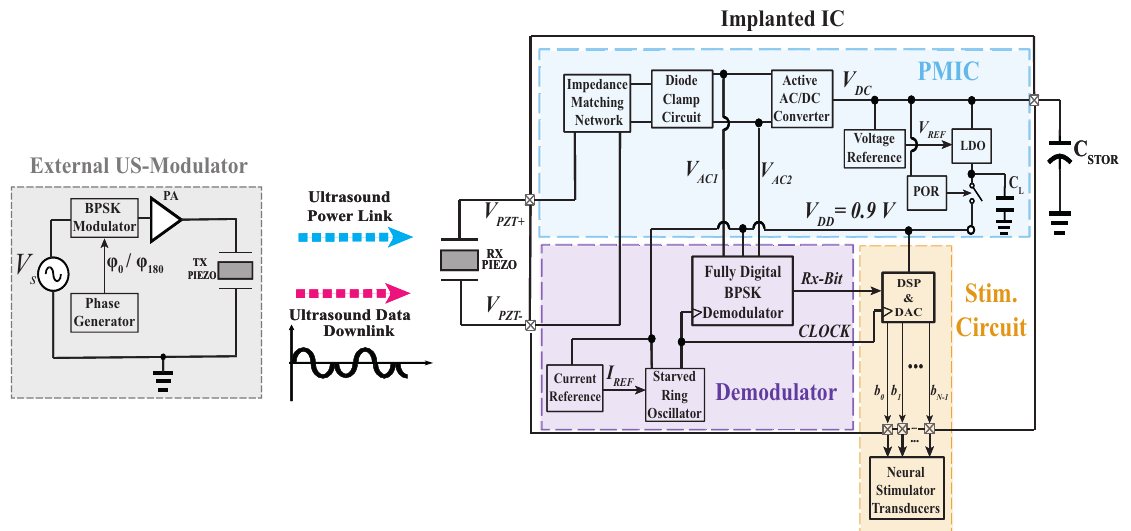
Figure 1. Simplified scheme of a US-powered